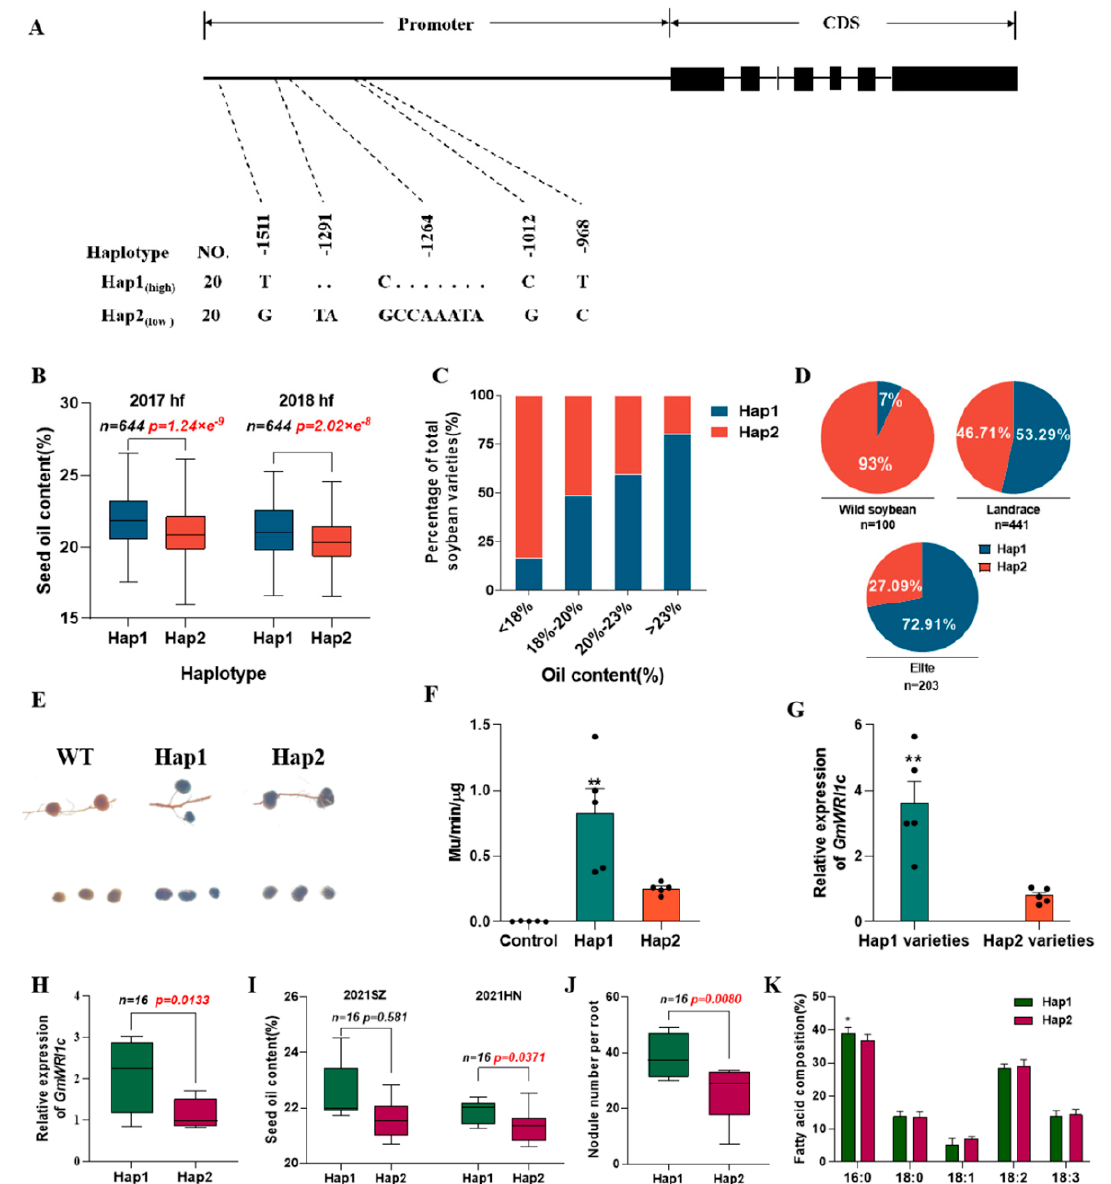
Figure 5. Effect of GmWRI1c on seed oil content and number of root nodules. ( A ) Haplotype analysis of GmWRI1c in 40 cultivated soybeans. ( B ) Boxplots of seed oil content for two haplotypes in 644 cultivated soybeans. ( C ) Percentages of two haplotypes of GmWRI1c in soybean lines grouped according to oil contents. ( D ) Distribution of two haplotypes of GmWRI1c in cultivated and wild soybeans. ( E ) GUS staining of transgenic nodules with gene expression driven by promoters of two GmWRI1c haplotypes. ( F ) Quantitative analysis of GUS activity in transgenic nodules ( n = 5). ( G ) GmWRI1c transcript levels in root nodules of different soybean cultivars ( n = 5). ( H – K ) Boxplots of gene transcript levels ( H ), seed oil contents ( I ), nodule numbers ( J ), and fatty acid composition ( K ) in soybean RILs with different haplotypes of GmWRI1c . 2017hf: grown in Hefei, China, in 2017. 2018hf: grown in Hefei, China, in 2018. 2021SZ: grown in Suzhou, China, in 2021. 2021HN: